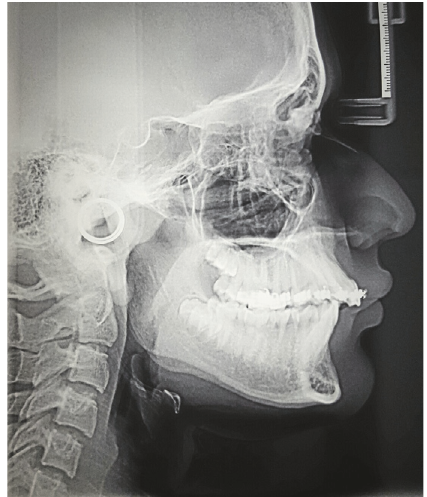
Figure 4: Cephalometric image after phase I (before starting Twin Block therapy): increased U1-SN angle and overjet are evident.